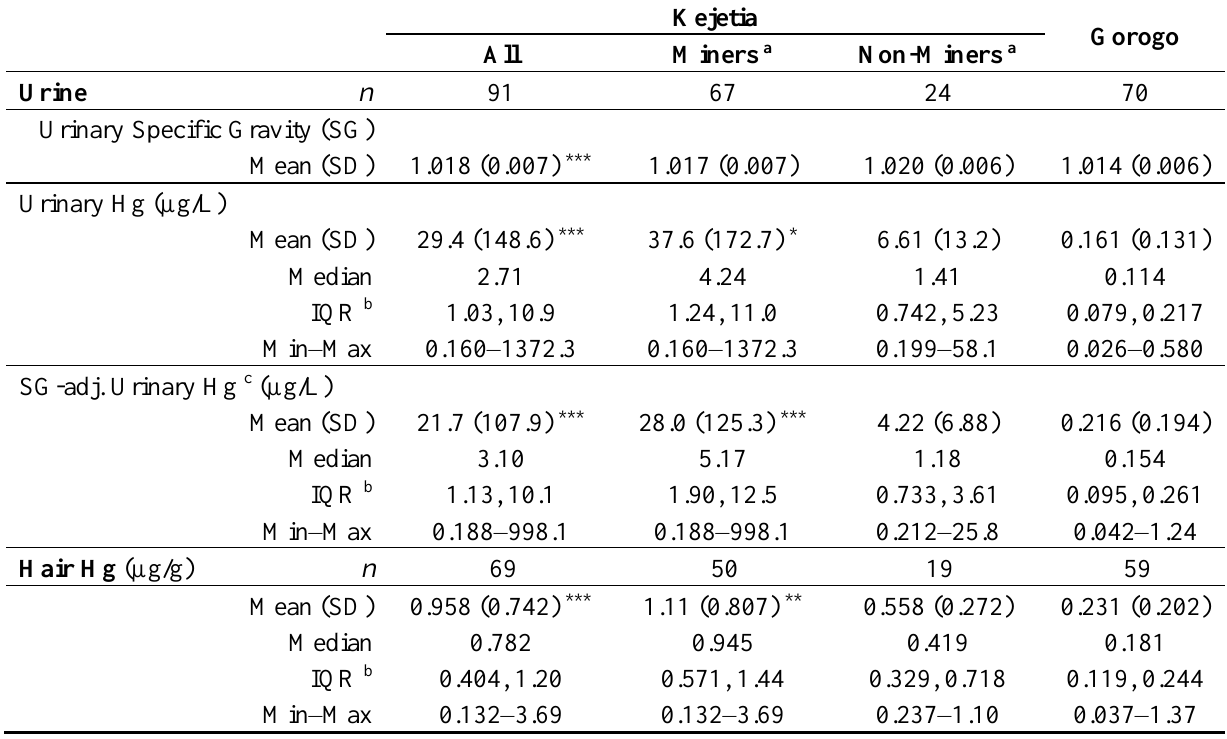
Table 3. Mercury concentrations in urine and hair samples of